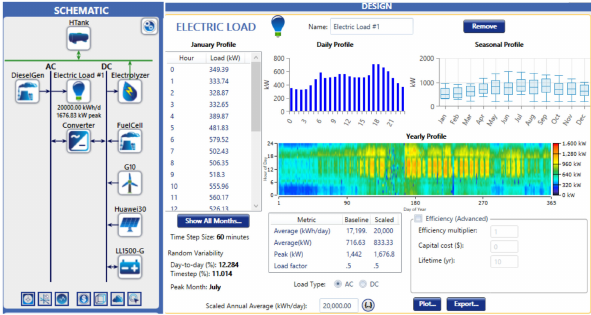
Figure 7. The schematic of the proposed HRES and input of Basco load